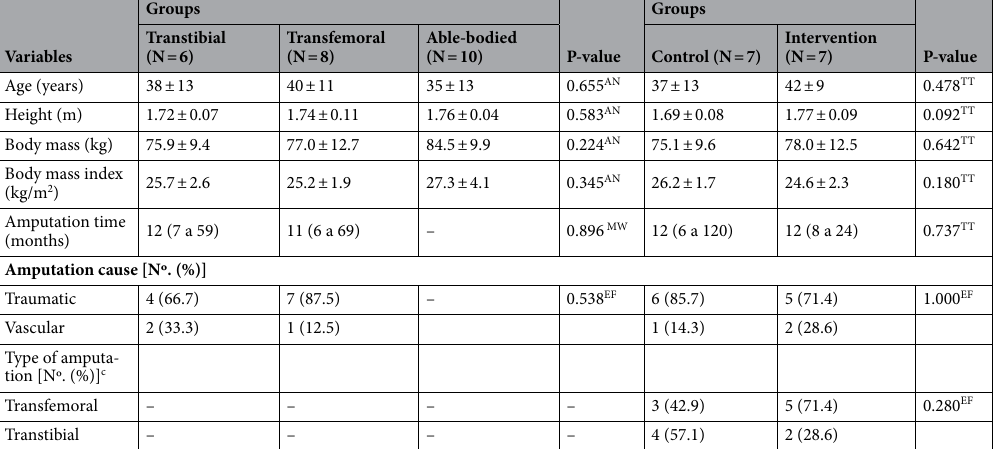
Table 2. Characterization of the total sample, divided by transtibial vs transfemoral amputation vs able- bodied group and by control vs intervention groups. Data are presented as mean ± standard deviation, median (1st to 3rd quartile) or frequencies of occurrence [No. (%)]. AN: One-way ANOVA; MW: Mann Whitney U-test; FE: Fisher’s exact test. TT: Student’s t-test; a Data presented as mean ± standard deviation; b Data presented as median (1st to 3rd quartile). c Data presented as absolute (N o .) and relative (%)